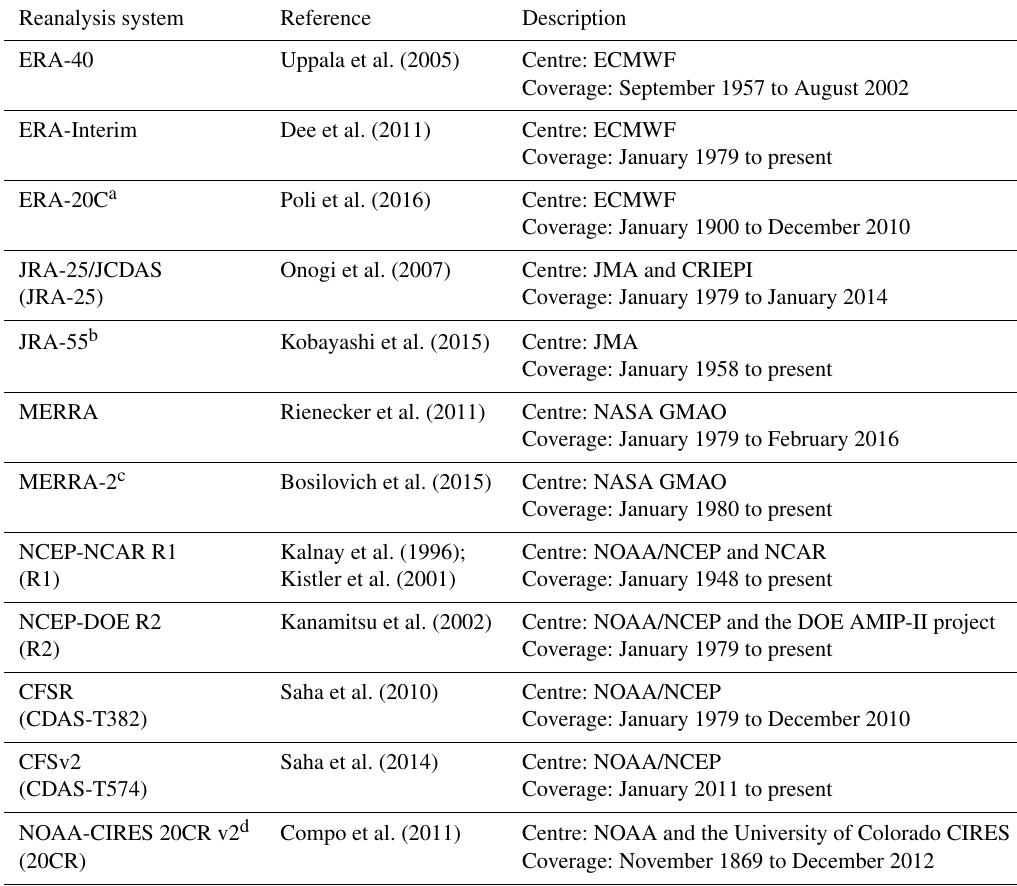
Table 1. List of global atmospheric reanalysis systems discussed in this